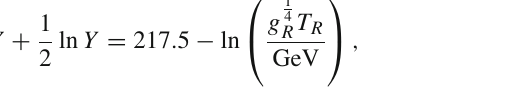
∼ = α − 2 H 2 M 2 ∗ and, thus, pl